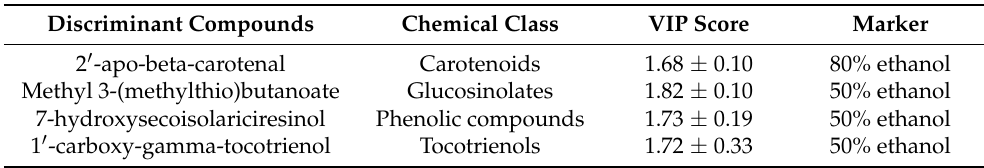
Table 5. Most discriminant compounds highlighted by VIP selection method following the OPLS- DA modelling and as a function of the % of ethanol (discriminant factor).